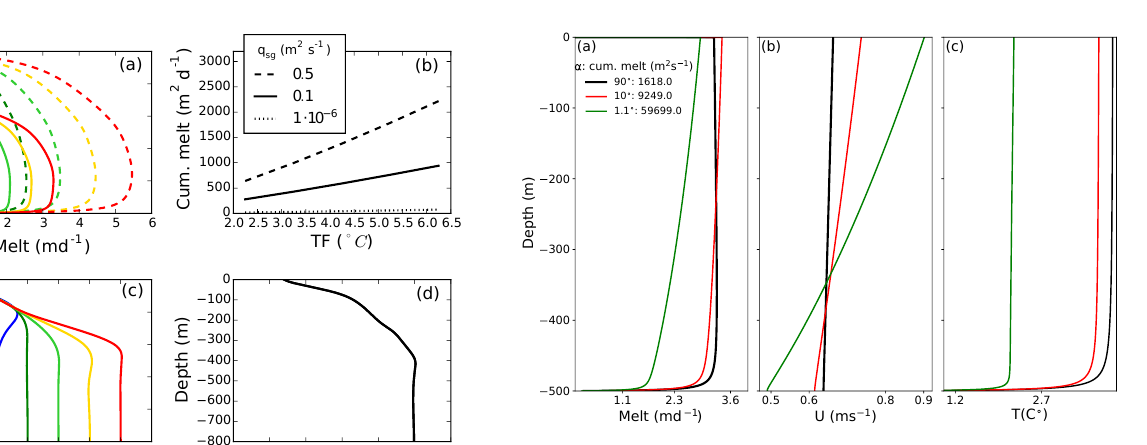
Figure 10. Melt profile (a) and corresponding plume velocity pro- files (b) plume temperature (c) and salinity (d) for the LP model for Figure 9. Influence of stratification and discharge on the melt rate different glacier types: a tidewater glacier ( α = 90 ◦ ), shelf glacier α = 10 ◦ and a shelf glacier with a long floating tongue ( α = 1 . 1 ◦ ) profile of the LP (a) . The three different discharge values ( q sg = 0 . 5, of 25km. The fjord is well mixed with T a = 4 ◦ C and S a = 34 . 2psu, 0.1, 10 − 6 m 2 s − 1 , dashed, solid, dotted) in a stratified environ- and the discharge was set to q sg = 0 . 1m 2 s − 1 with E 0 = 0 . 1. Note ment for a fixed salinity profile (d) and five different tempera- that the profiles of α = 90 ◦ and α = 10 ◦ are very similar but the cu- ture profiles (c) result in 15 different melt rate profiles. The melt mulative melt rate of the shelf glacier increased on 500%. For the rate of the corresponding temperature profile is displayed in the long floating tongue the cumulative melt rate is an order of magni- same color as well as in the same style (dashed, dotted or solid) tude for the corresponding discharge. Note that a very high discharge ( q sg = 0 . 5m 2 s − 1 ) is needed for the plume to reach the surface. For each discharge value the corresponding cumulative melt rate is depicted (b) as a function of the thermal forcing ( (cid:49)T a = T a − T b , β Eq. 7) at the grounding line. For ˙ m ∼ (cid:49)T a we found β values of 1.2 for ( q sg = 0 . 5m 2 s − 1 ), 1.2 for ( q sg = 0 . 1m 2 s − 1 ) and 1.4 for ( q sg = 10 − 6 m 2 s − 1 ).